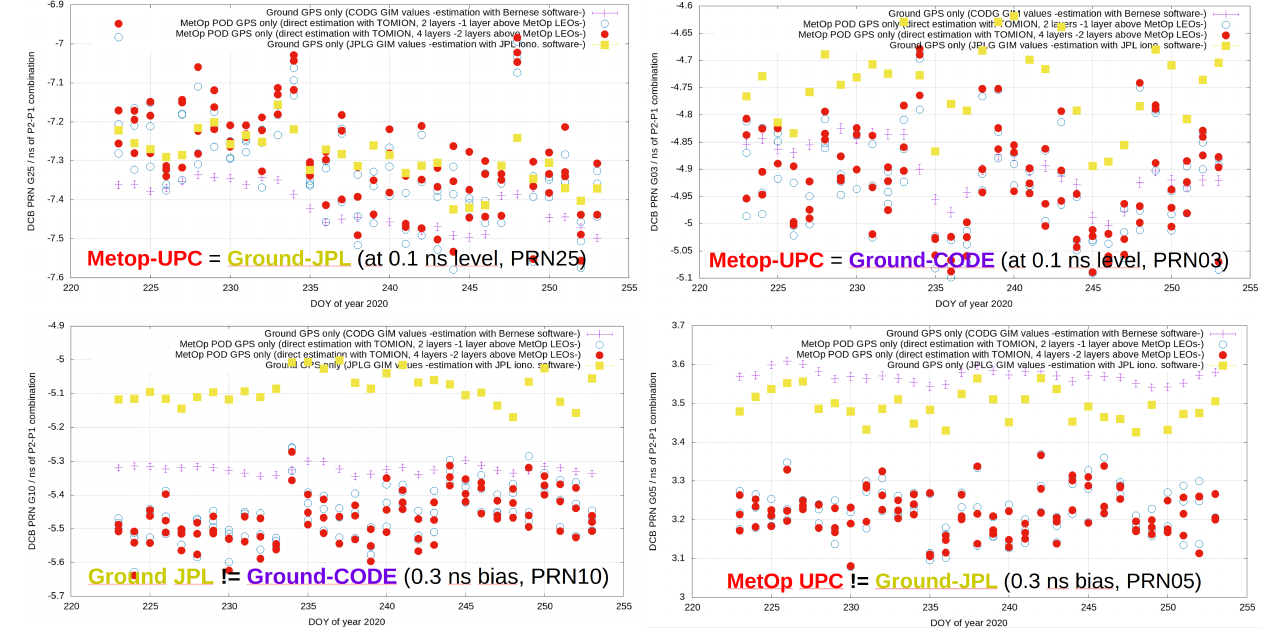
Figure 3. Four typical examples of comparison of GPS transmitter DCBs obtained by TOMION runs based on MetOp LEO data only (2 and 4 layers, i.e., 1 and 2 layers above) vs. ground-based values from IGS centers (CODE and JPL): PRN25 ( top − left ), PRN03 ( top − right ), PRN10 ( bottom − left ) and PRN05 ( bottom − right